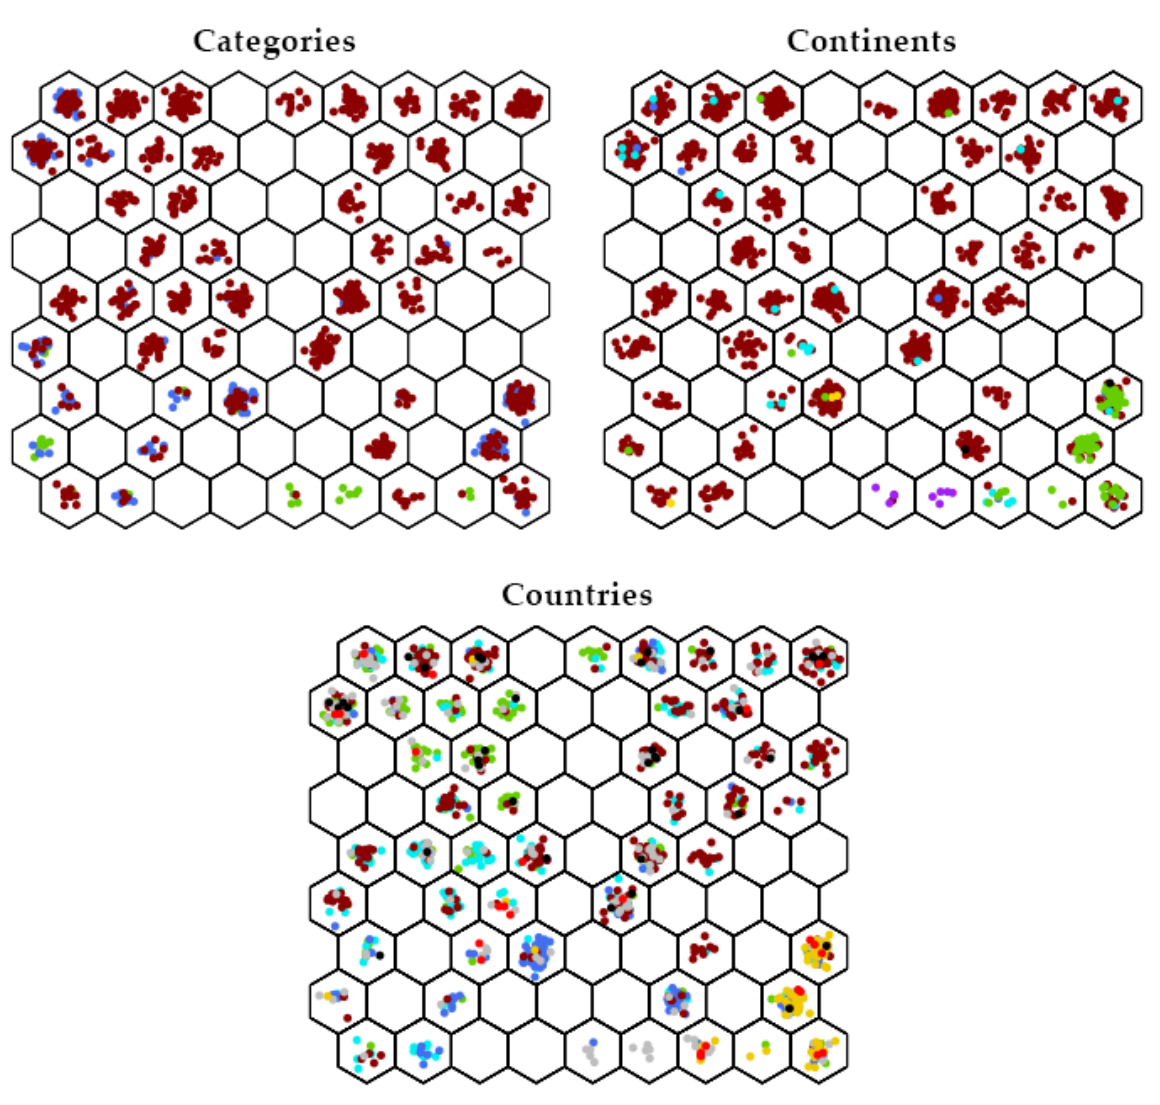
Figure 3. Distribution of potato accessions for 3 different sets of information. “Categories” shows heirloom accessions in green, old accessions in blue and modern accessions in red. “Continents” shows North American accessions in green, South American accessions in purple (Andigena) and in yellow (from Chiloe Island), European accessions in red, African accessions in blue, Asian accessions in cyan, Oceanian accessions in black. “Countries” shows accessions from Austria in black, from China in light red, from France in cyan, from Germany in green, from the Netherlands in dark red, from United Kingdom in blue, from the USA in yellow, and all other accessions in gray.